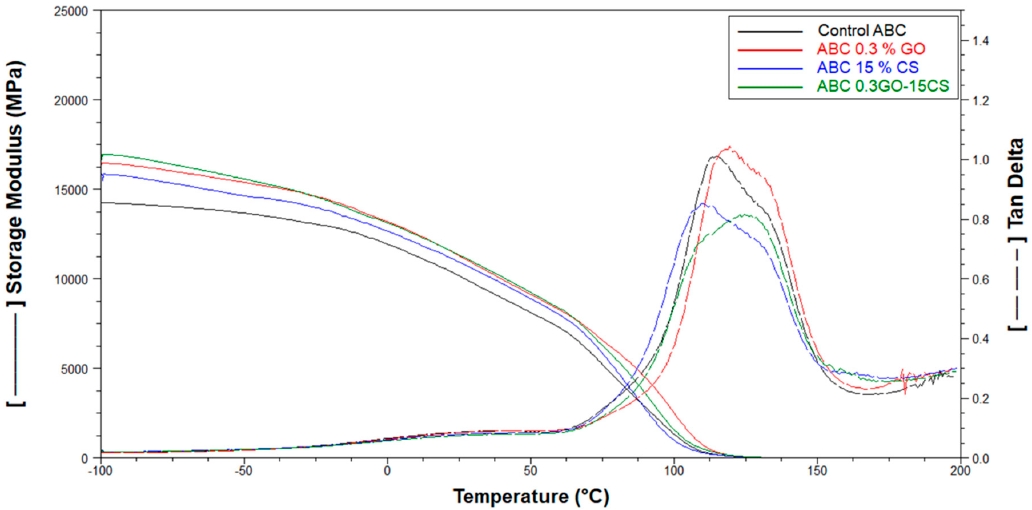
Figure 7. DMA results for the control ABC and experimental cements formulated with graphene oxide (GO) and chitosan (CS).